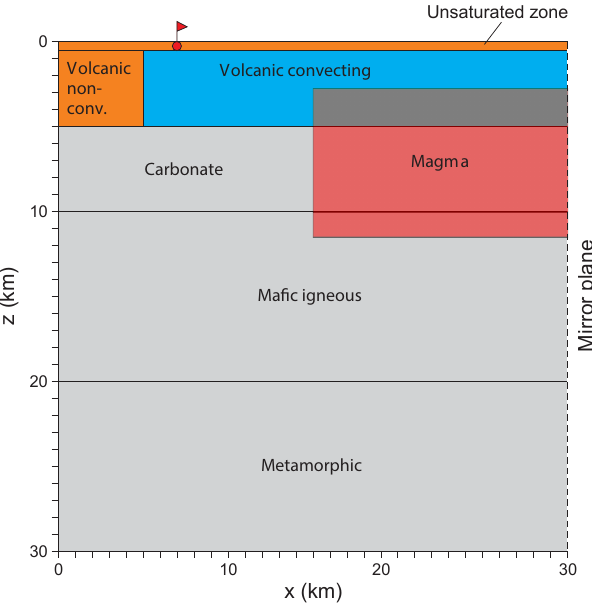
Figure A2. Mesh used by Whelan et al. (2008). The temperatures were modeled for the reference points, located at z = 200–300m from surface (lateral position is marked by a flag; not to scale). Wa- ter convection was allowed in the “volcanic convecting” domain.